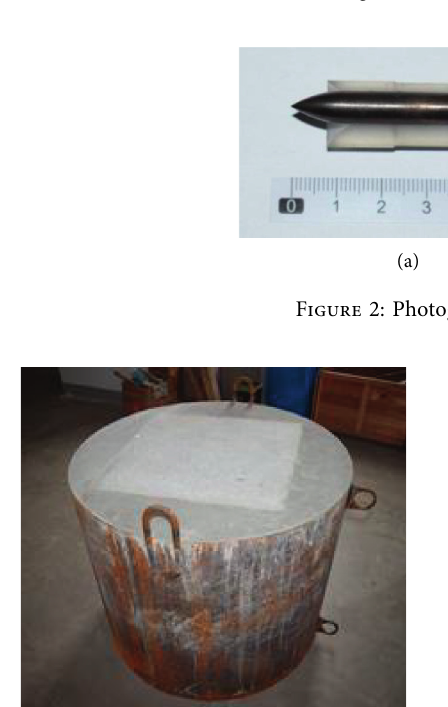
Figure 1: Schematic diagram of the experimental system for a two-stage light gas gun.